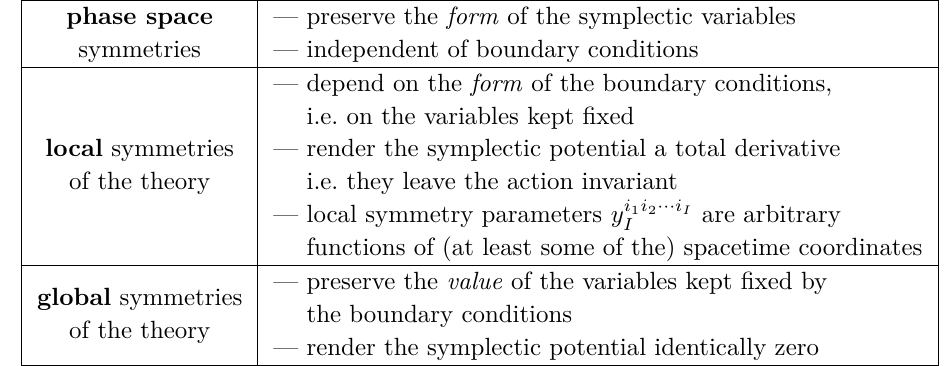
Table 1 . Glossary of symmetries discussed in this paper. The term “theory” refers to the phase space together with a specification of the variables kept fixed in the variational principle, i.e.